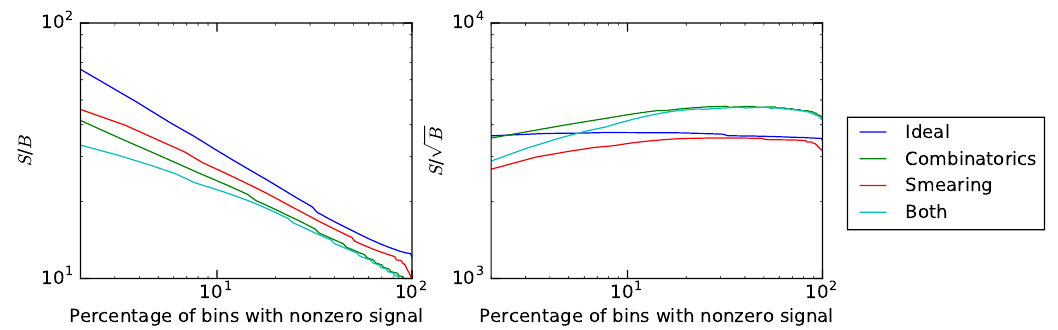
Figure 6 . The e(cid:11)ect of energy resolution and combinatorics on the signi(cid:12)cance performance curve of (cid:1) 4 is shown using the S = B (left panel) and S = p B (right panel) metrics.